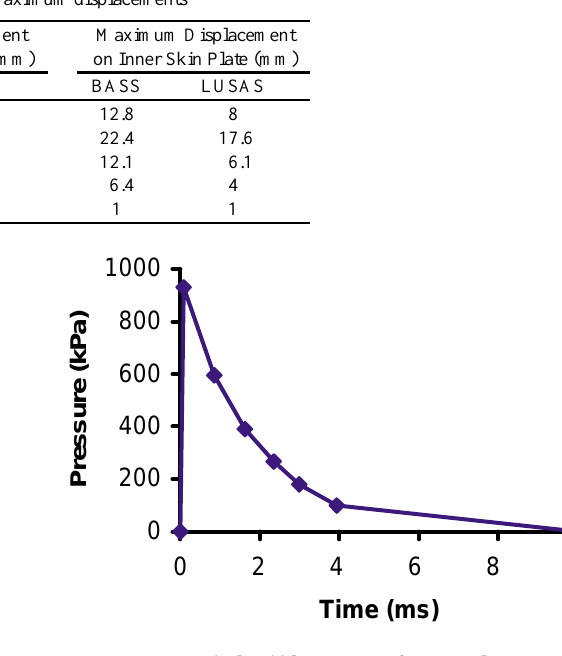
Fig. 8. Idealized blast pressure for Example 3.